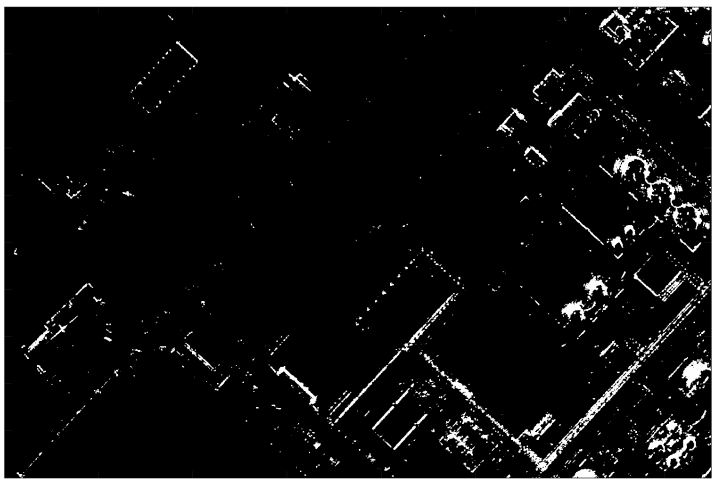
Figure 11. The binary image obtained by Rayleigh